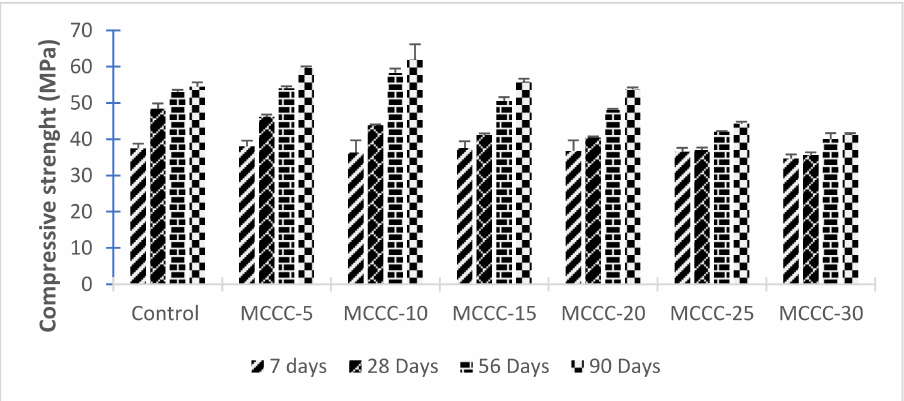
Figure 10. Compressive strength development of MCC-based